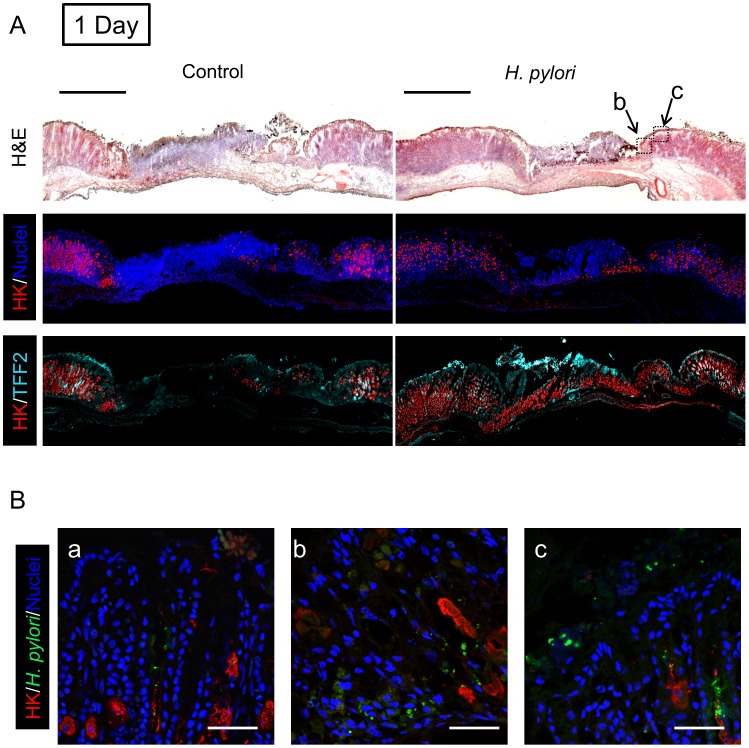
Morphology of gastric ulcerated tissue 1 day after H. pylori inoculation.Gastric ulcer was induced by topical serosal application of acetic acid. In some animals, a single gavage of 106 SS1 H. pylori was performed 2 days after ulcer induction. Gastric tissue was isolated 3 days after ulcer induction (1 Day after H. pylori inoculum), and serial sections processed as described in Methods. Results are compared from the same tissue and sectioning series, although adjacent sections are not always presented. (A) Sections of uninfected (control) or H. pylori infected tissues are compared. Images show H&E staining, dual staining for H,K-ATPase (HK: red) and cell nuclei (blue), and dual stain for H,K-ATPase (HK: red) and TFF2 (cyan). Bar = 1 mm. (B) Tissue was also stained for H. pylori. Higher magnification of serial sections from (a) non-ulcerated corpus region of H. pylori infected stomach, or (b, c) around inset area (Z-focal plane ± 50 µm) indicated in A (H&E staining). Cell nuclei (blue), H. pylori (green), H,K-ATPase (HK: red). Bar = 50 µm.